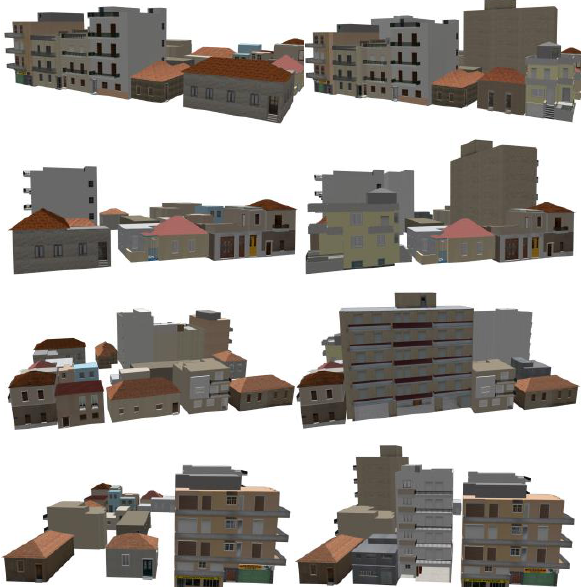
Figure 10. 3D views of the building models of an urban block in the years 1983 (left) and 2010 (right) at LoD3